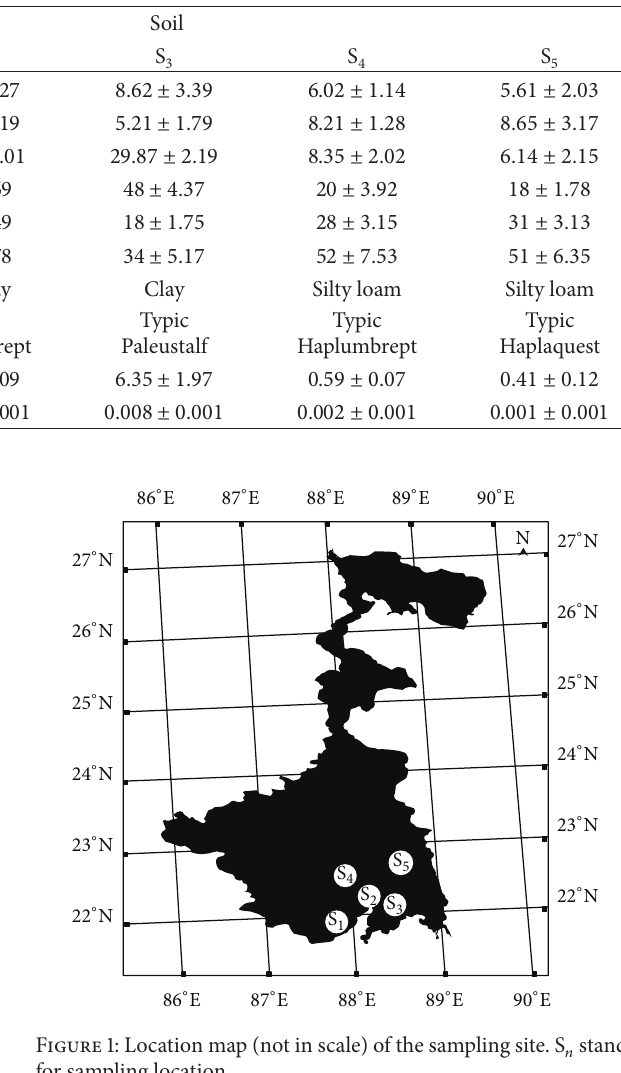
Table 1: Physicochemical properties of the five experimental soils collected from different agroecological zones of West Bengal, India (data represent mean of tree replications ± SD).